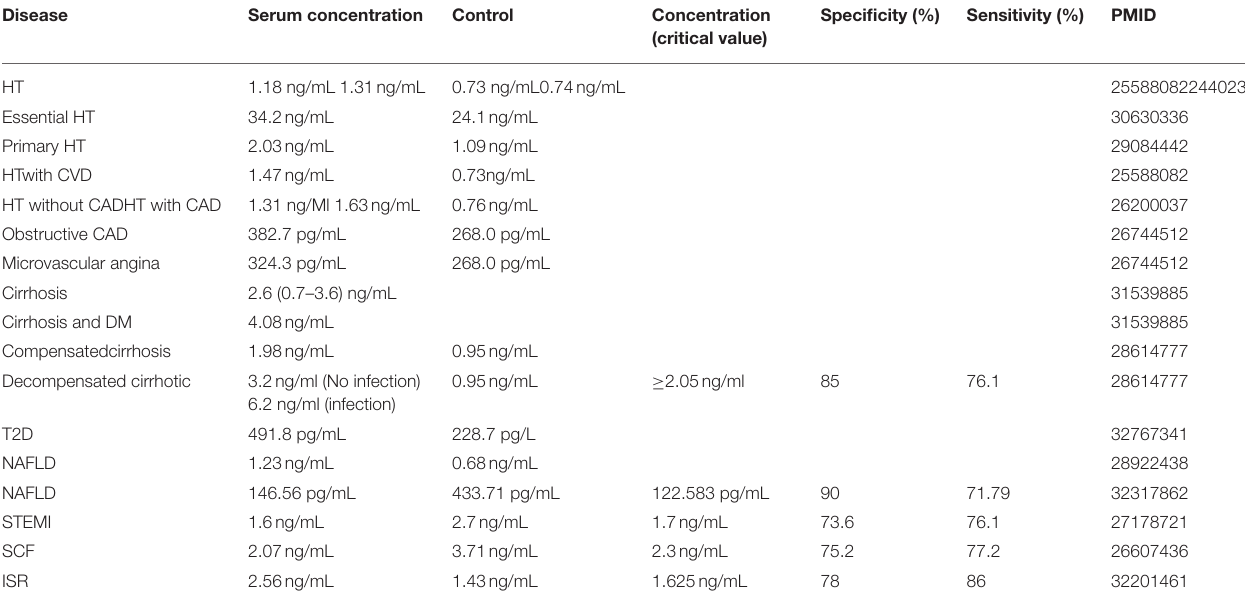
TABLE 1 | Serum concentration, specificity and sensitivity of endocan in diseases. Disease Serum concentration